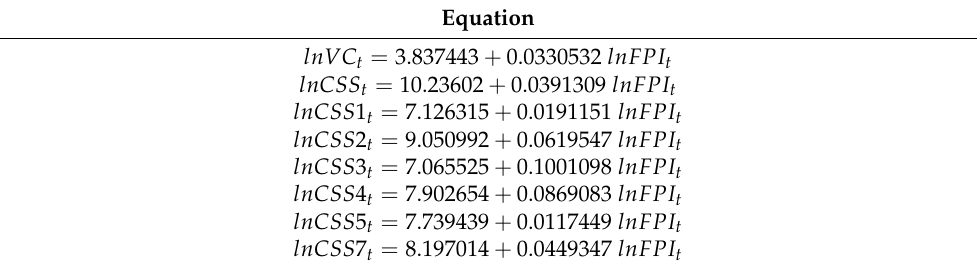
Table A3. Results of the ordinary least squares estimation of the coefficient of